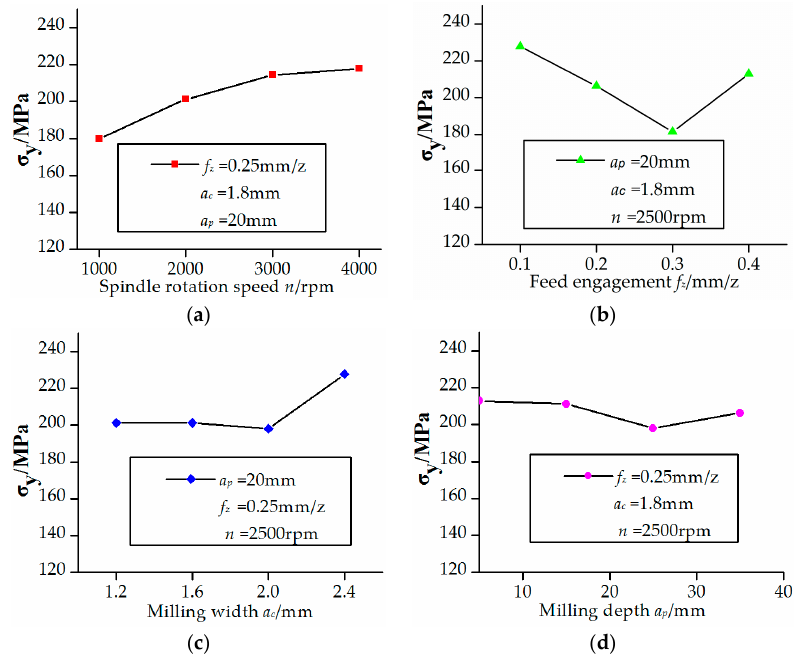
Figure 4. Effects of control factors on Y -direction residual stress. ( a ) Relationship between spindle rotation speed and residual stress; ( b ) Relationship between feed engagement and residual stress; ( c ) Relationship between milling width and residual stress; ( d ) Relationship between milling depth and residual stress.